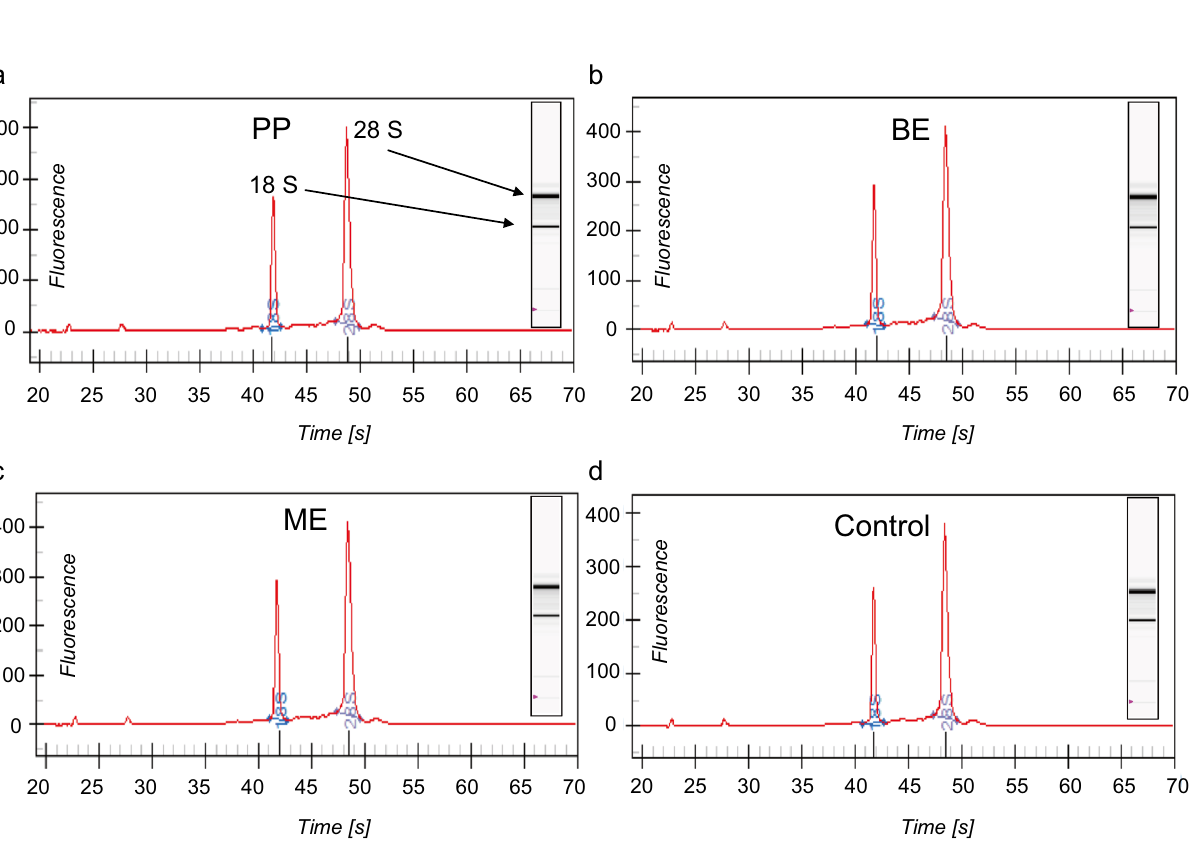
Figure 5. Exemplary electropherograms and virtual gels derived for HGK exposed to PP ( a ), BE ( b ), and ME ( c ) 24 h eluates, as well as unexposed HGK (control, d ). In the electropherogram, the two peaks depict the 18S and 28S rRNA (arrows in a ). The virtual gel (inserts in a – d ) is reconstructed based on the peaks and the total RNA